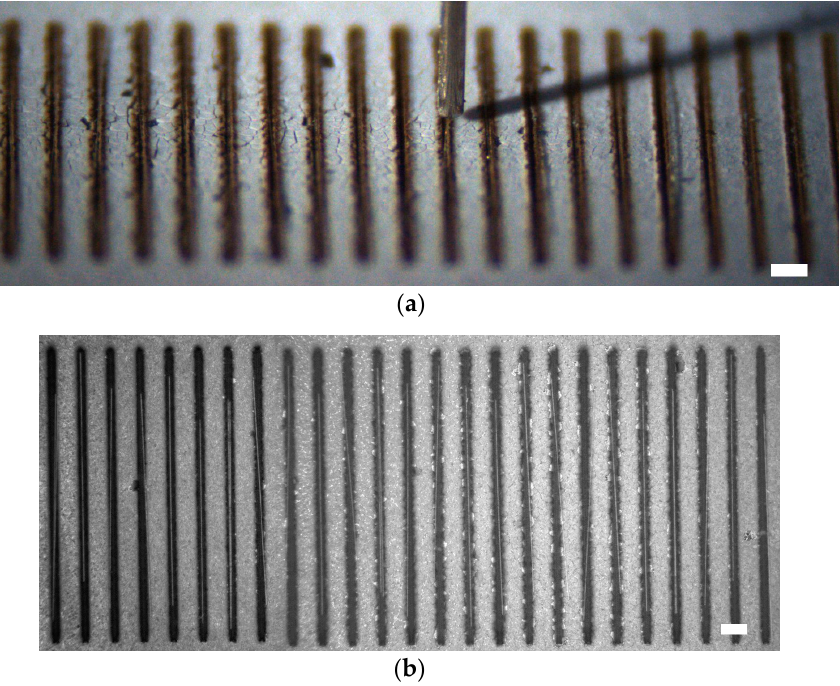
Figure 10. Alignment of 25 microfibers to parallel grooves: ( a ) Titled view of a fiber released to the corresponding hydrophilic–superhydrophobic groove; ( b ) Top view of 25 fibers aligned to the corresponding grooves. Scale bar: 200 µm.